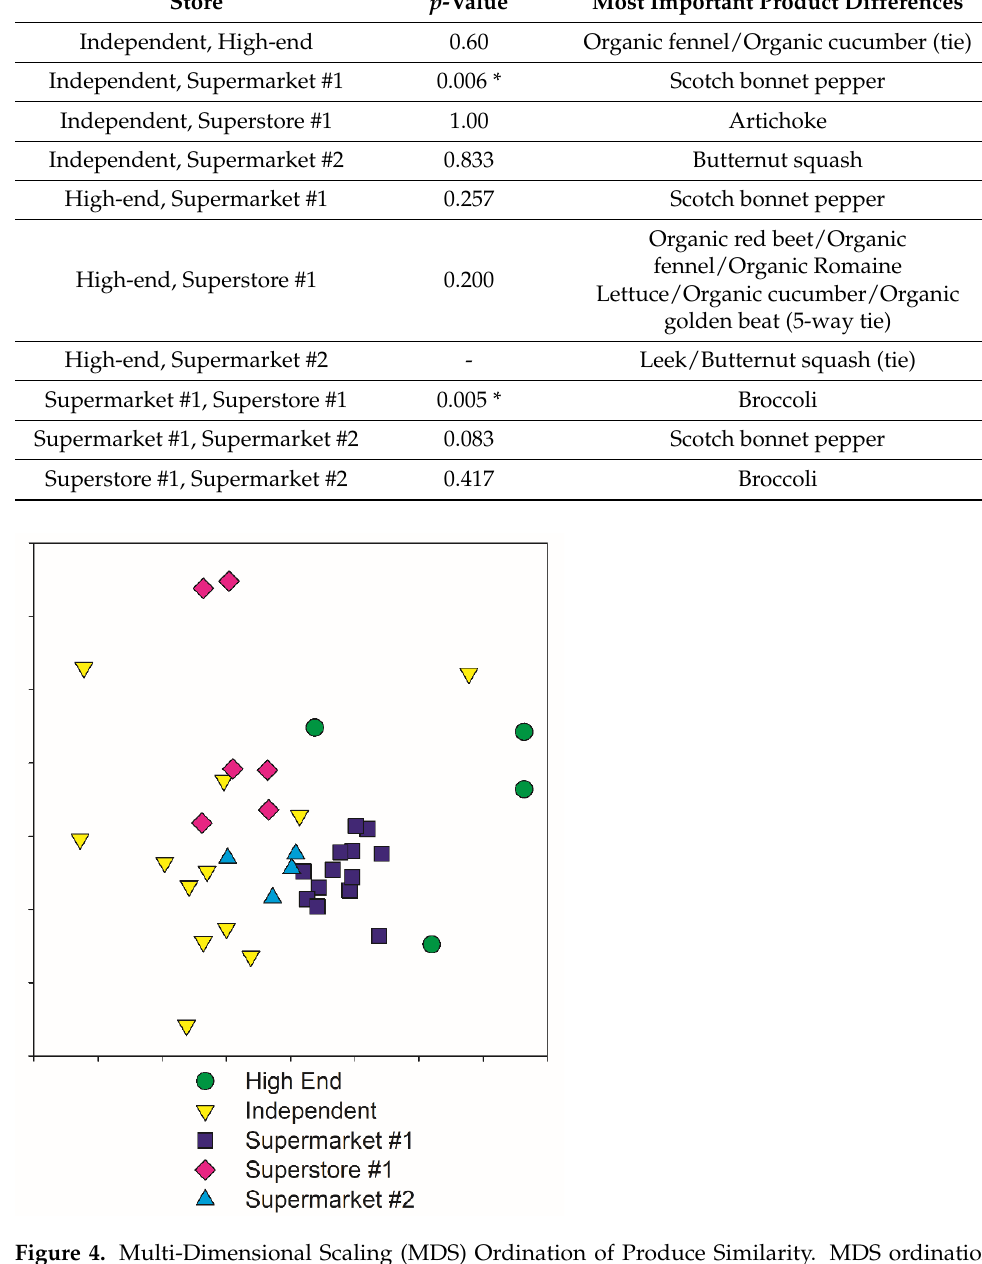
Table 3. Pairwise comparisons of similarity between store classifications. Pairs of store classifications that are significantly different noted with an “*”. The third column shows the most important product contributing to differences between the stores as indicated by SIMPER.